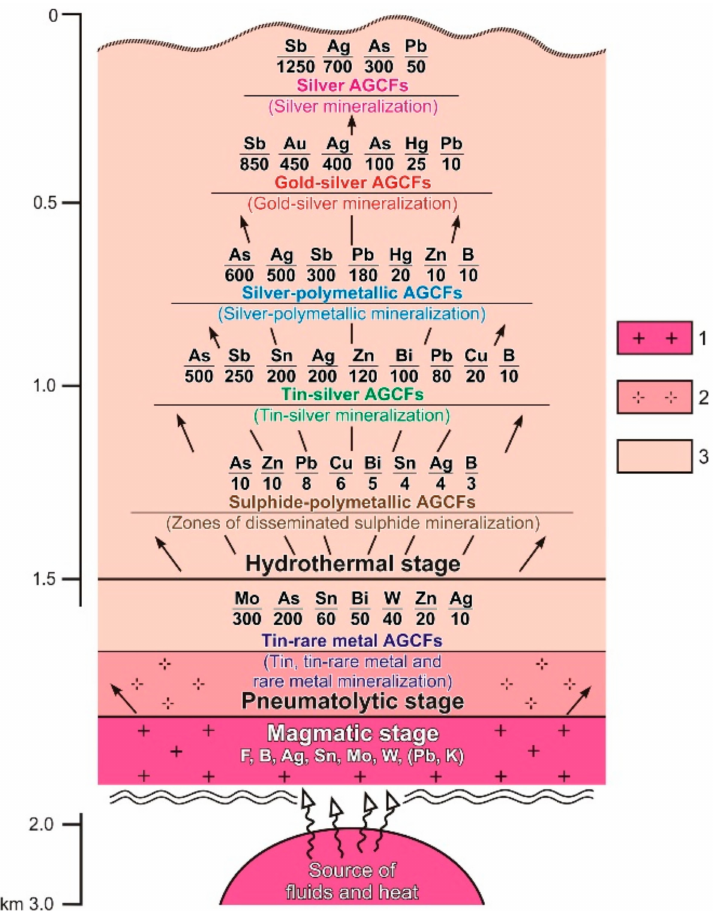
Figure 14. A distribution scheme of mineralization and endogenous AGCFs of the Ducat Au – Ag system [16,84]. 1—granites, 2—leucogranites, and 3—rhyodacites. Below the line, the average CR values of the elements are given, determined in the field contours of their maximum